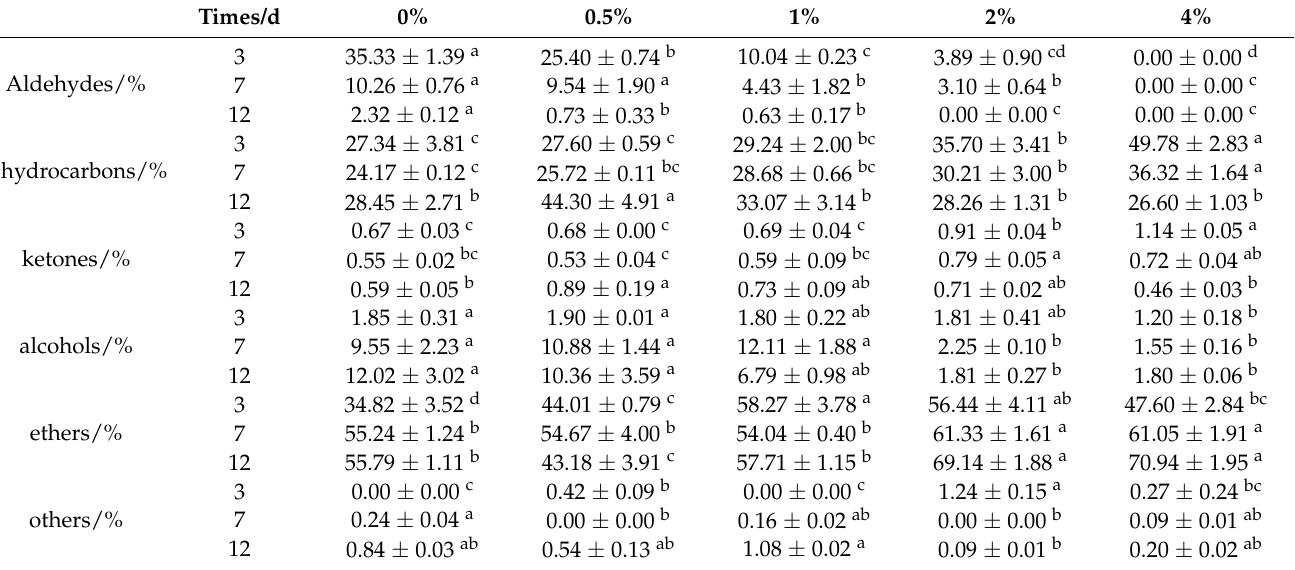
Table 4. Effects of LNT content on substance content of goose meatballs during cold storage (4 ◦